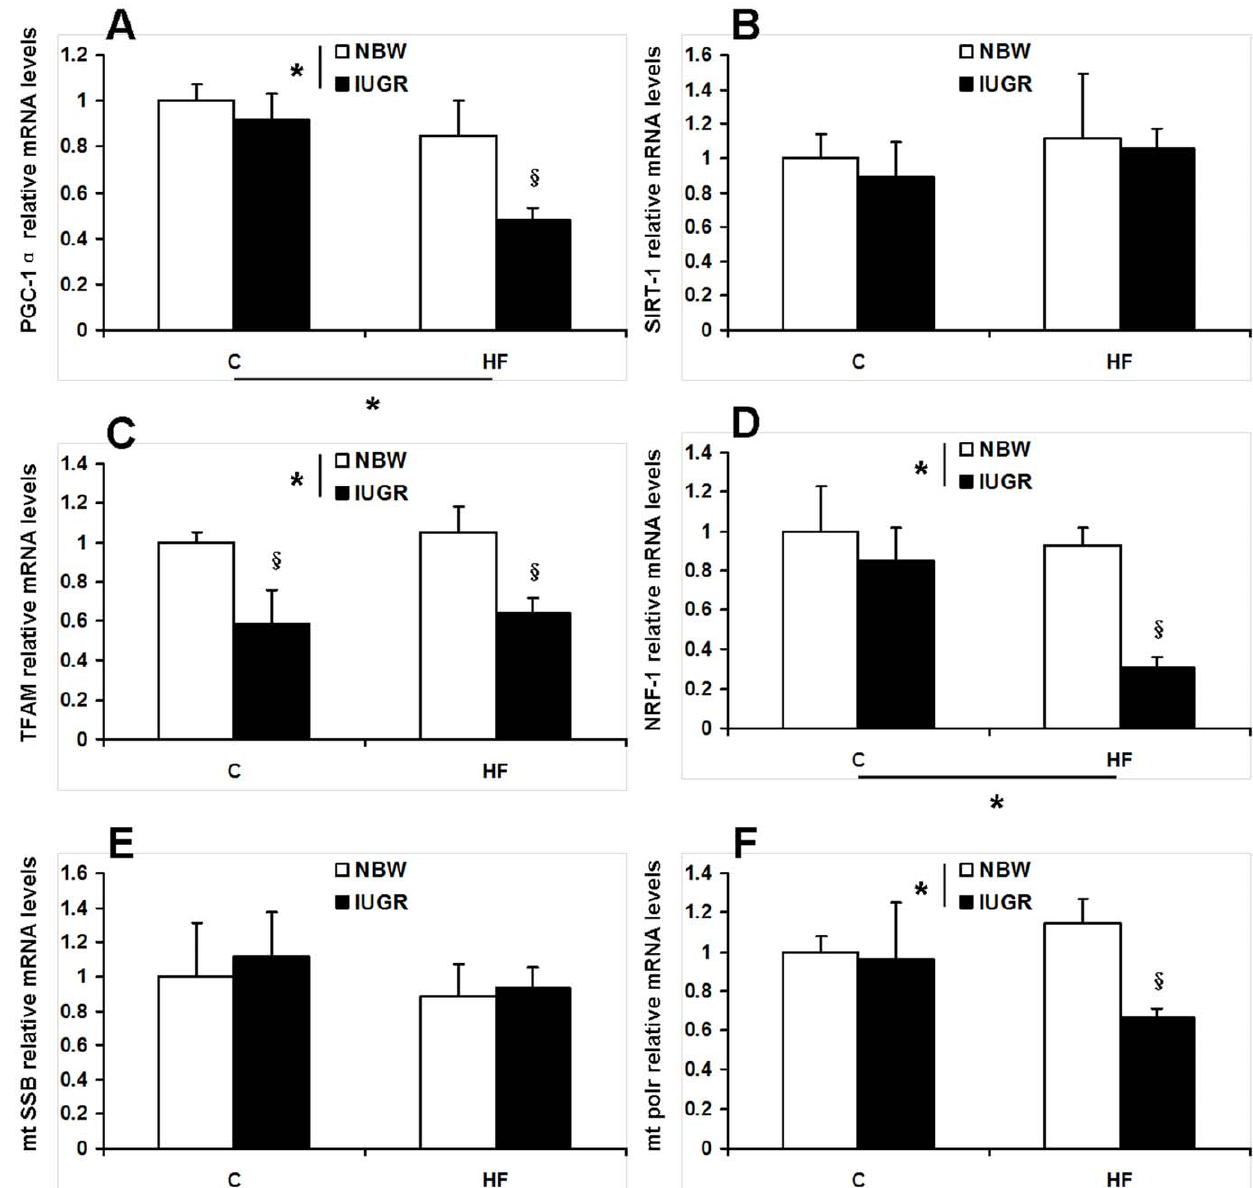
Figure 8. Influence of IUGR and diet on mRNA levels of peroxisomal proliferator-activated receptor- c coactivator-1 a (PGC-1 a , A), mitochondrial transcription factor A (TFAM, B), mammalian silencing information regulator-2 a (SIRT-1, C), nuclear respiratory factor-1 (NRF-1, D), mitochondrial single-strand DNA-binding protein (mt SSB, E) and mitochondrial polymerase r (mt polr, F) in skeletal muscle of pigs. C: Control diet; HF: High-fat diet; NBW: Normal birth weight; IUGR: Intrauterine growth retardation. Data are expressed as group means 6 SEM. * P values next to each label represent the significance in the effect for each source of variation (IUGR or diet) as calculated by ANOVA. 1 P , 0.05 in post hoc test comparing IUGR and NBW offspring receiving the same diet (n=8 by group).